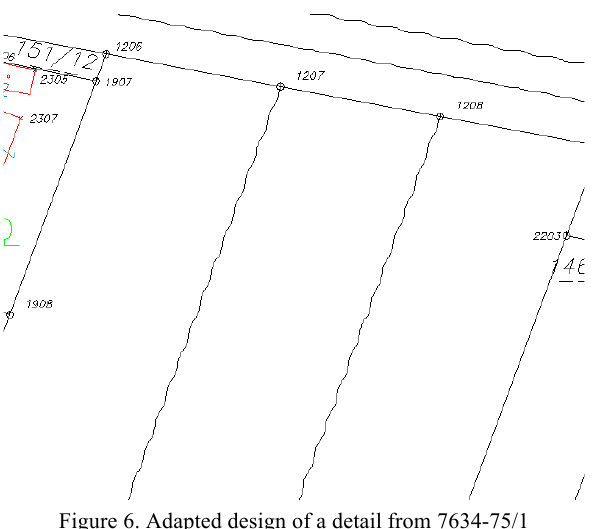
Figure 6. Adapted design of a detail from 7634-75/1 (Leopoldseder, 2015, p. 35, data: © BEV) A final adaptation was to rotate the lines by a small amount. In Figure 6, all adapted lines do meet the boundary points. The non-expert should be informed that this is not guaranteed.